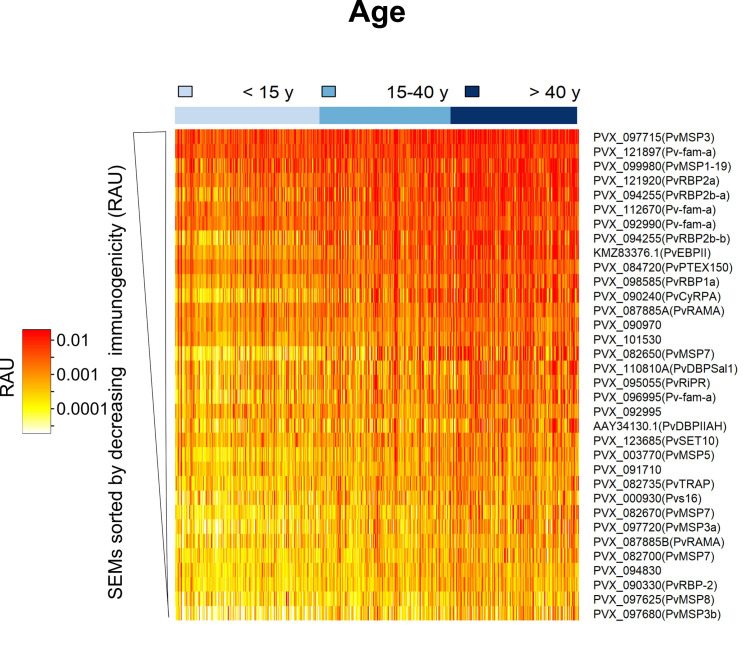
Heatmap of antibody responses to P. vivax serological exposure markers in the Peruvian cohort.Relative antibody units (RAU) were log10 transformed. Each vertical line represents a participant sorted by increasing age (3–85 years old). Immunogenicity of SEMs was defined as the geometric mean of log10 (RAU) across all participants in the Peruvian cohort. We used this quantitative metric to sort the antibody responses.